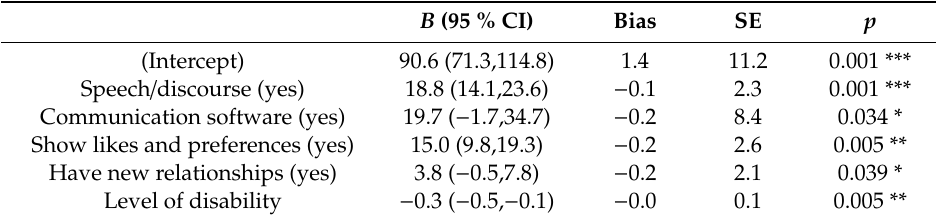
Table 8. Bootstrapped robust multiple regression coe ffi cients (CSN group).